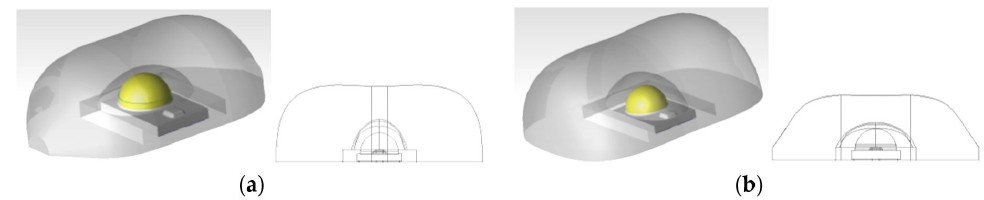
Figure 13. Geometric structure diagram of a roadway lighting lens: ( a ) Type A; ( b ) Type